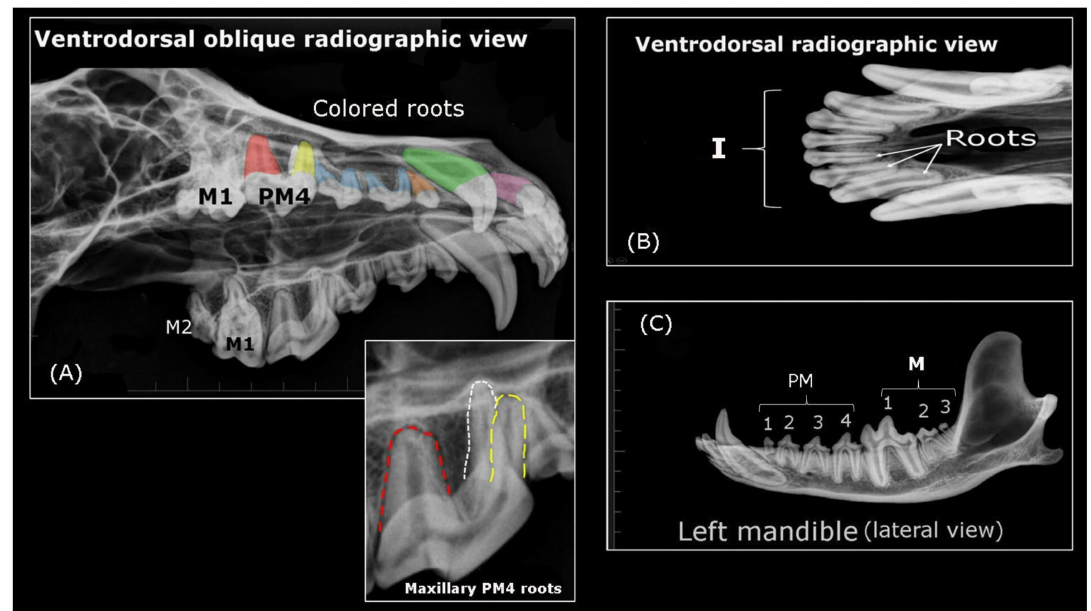
Figure 3. Radiographic views of the wolf‘s teeth and skull. ( A ) (Upper image) Right I3 root (purple), right canine root (green), PM1 root (orange), PM2 and PM3 roots (blue) and PM4 roots (white, red and yellow); (Lower image). Detail of the PM4 roots-mesiobuccal (yellow dotted line), mesiopalatal (white dotted line) and distal root (red dotted line); ( B ) Roots of three right maxillary incisors; ( C ) Molar and premolar disposition teeth in the mandible.